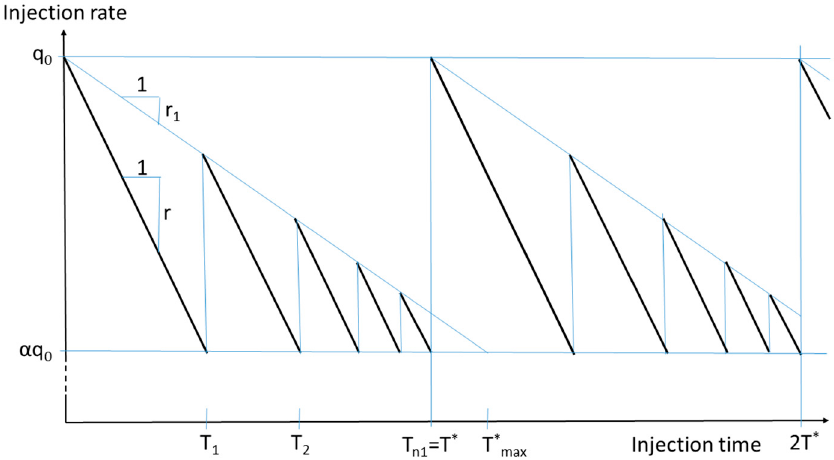
Figure 4. Simple four-constant model of injection rate as a function of injection time with an acute rate of decline (r) of the injection rate, q (t inj ) during injection, purges initiated at the injection rate, α q 0 , injection rate resuming at a rate of chronic decline (r 1 ), and major redevelopments initiated when the volume of water purged exceeds η times the volume of water injected in the previous cycle.